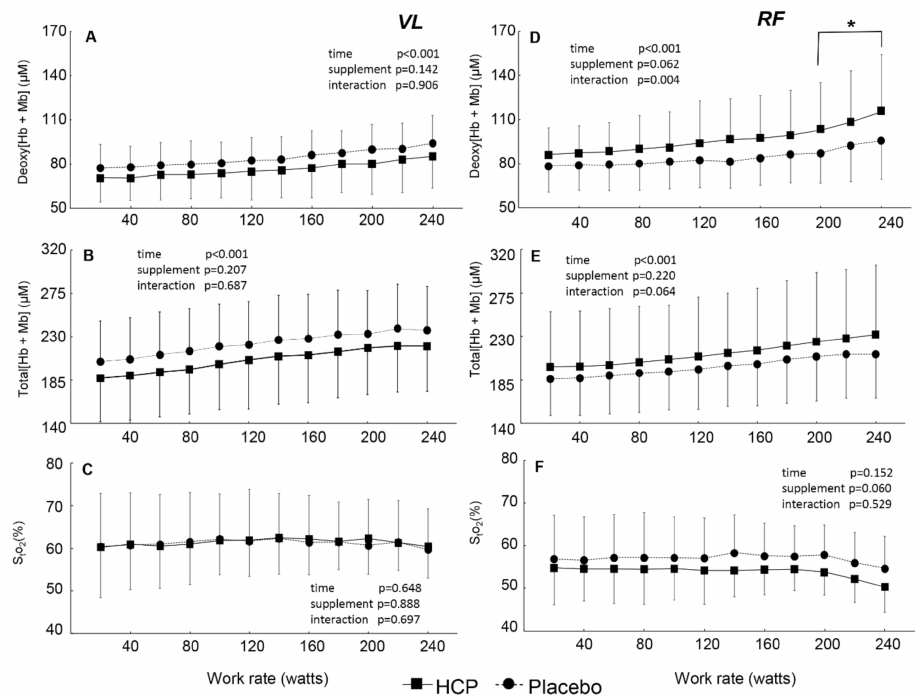
Figure 3. Group mean values for the vastus lateralis (VL) muscle deoxygenated hemoglobin and myo- globin concentration (deoxy[Hb + Mb]) ( A ), total hemoglobin and myoglobin concentration (total[Hb + Mb]) ( B ), tissue O 2 saturation (S t O 2 ) ( C ), and rectus femoris (RF) muscle deoxy[Hb + Mb] ( D ), total[Hb + Mb] ( E ), and S t O 2 ( F ) versus the power output during cycle exercise in the HCP and placebo groups. Error bars: SD. Significant difference between HCP and placebo at higher work rates; * p <